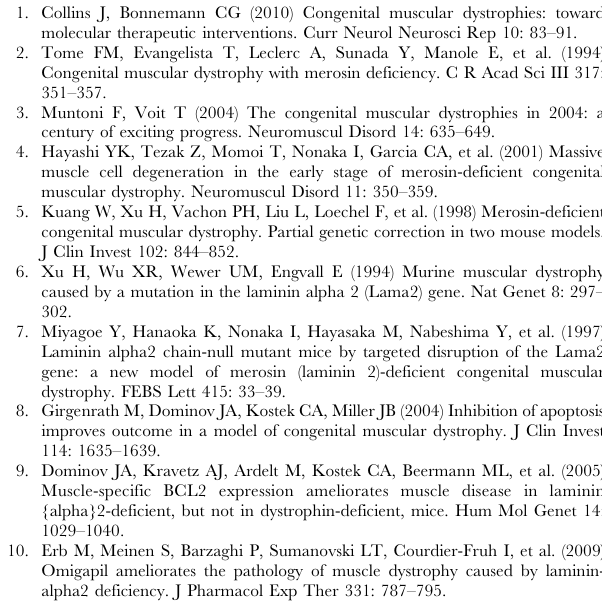
Table S2 Outcome measures for BL6 control, vehicle and Omigapil treated dy2J mice at 22-25 weeks of age when mice were treated for 10 weeks. Table S3 Outcome measures for BL6 control, vehicle and Omigapil treated dy2J mice at 26-29 weeks of age when mice stopped treatment for 4